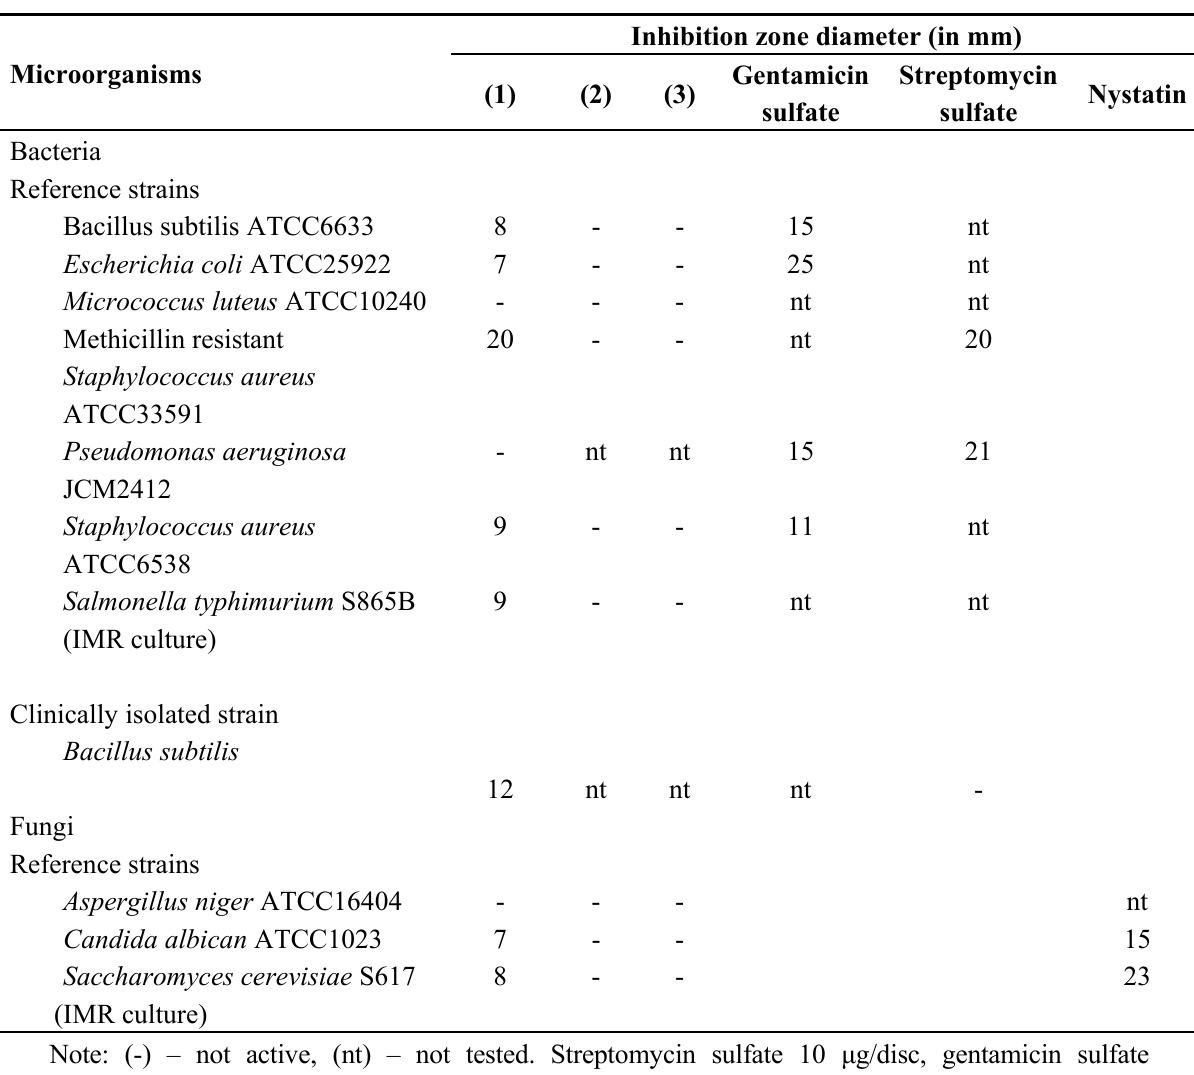
Table 2. The inhibition zone diameter (in mm) of pyranocycloartobiloxanthone A ( 1 ), dihydroartoindonesianin C ( 2 ) and pyranocycloartobiloxanthone B ( 3 ) against pathogenic